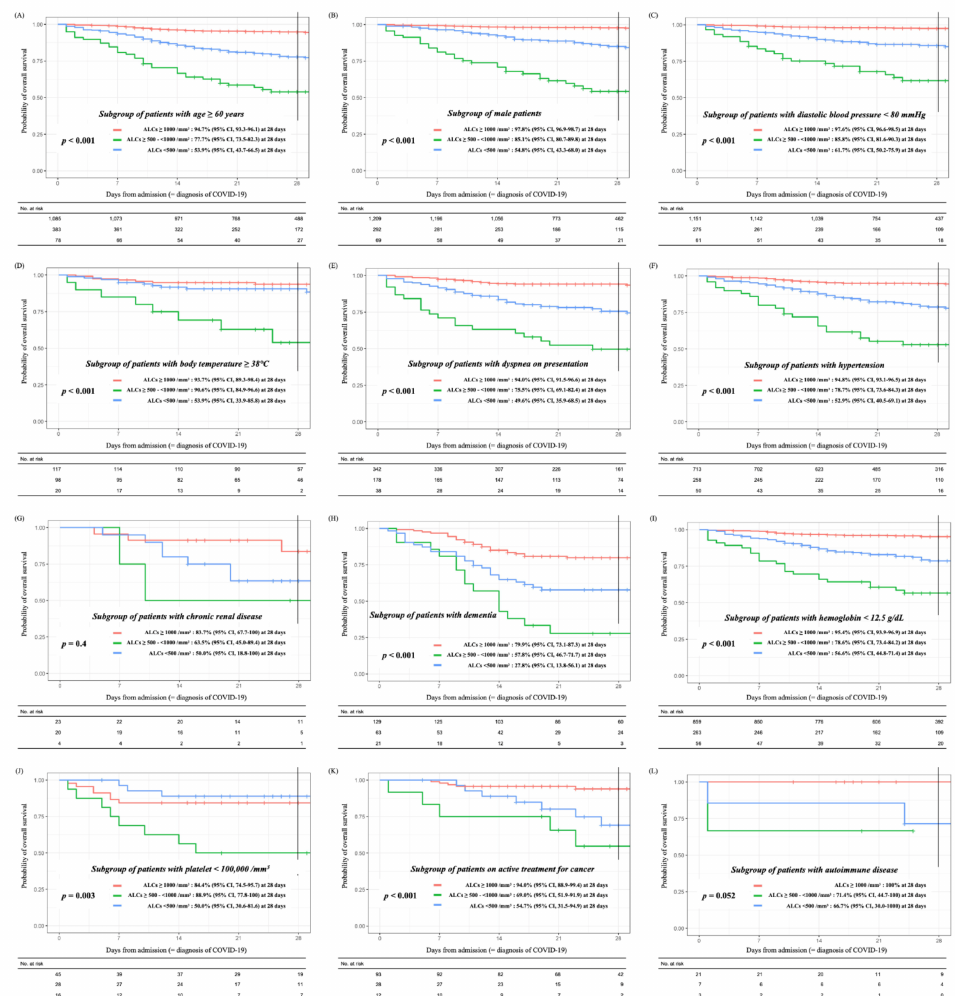
Figure 5. Overall survival outcomes for lymphopenia according to subgroups. The subgroups are as follows: ( A ) patients with age ≥ 60 years ( n = 1546), ( B ) male patients ( n = 1570), ( C ) patients with diastolic blood pressure < 80 mmHg ( n = 1487), ( D ) patients with body temperature ≥ 38 ◦ C ( n = 235), ( E ) patients with dyspnea on presentation ( n = 558), ( F ) patients with hypertension ( n = 1021), ( G ) patients with renal disease ( n = 47) ( H ) patients with dementia ( n = 213) ( I ) patients with hemoglobin <12.5 g/dL ( n = 1178), ( J ) patients with platelet < 100,000/mm 3 ( n = 89), ( K ) patients on active treatment for cancer ( n = 133), and ( L ) patients with autoimmune disease ( n = 31). Abbreviation: ALC, absolute lymphocyte